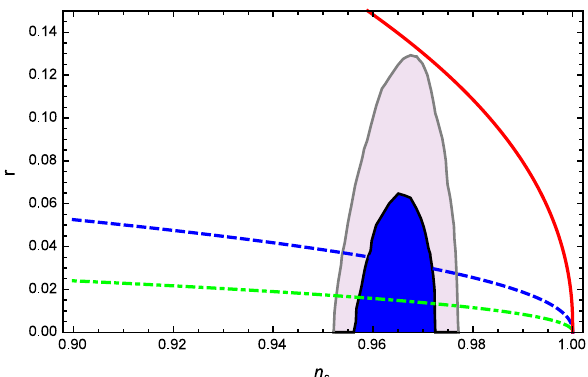
Fig. 2 1 σ and2 σ confidenceregionsborrowed fromPlanck[47], r – n s trajectories of the present model. The dot-dashed green , dashed blue and solid red lines related to pairs ( 29 . 12 × 10 − 3 ),( 3 × 10 − 12 ) and ( 69 × 10 − 50 ) . The trajectory located out of 95% confidence for the large value of λ